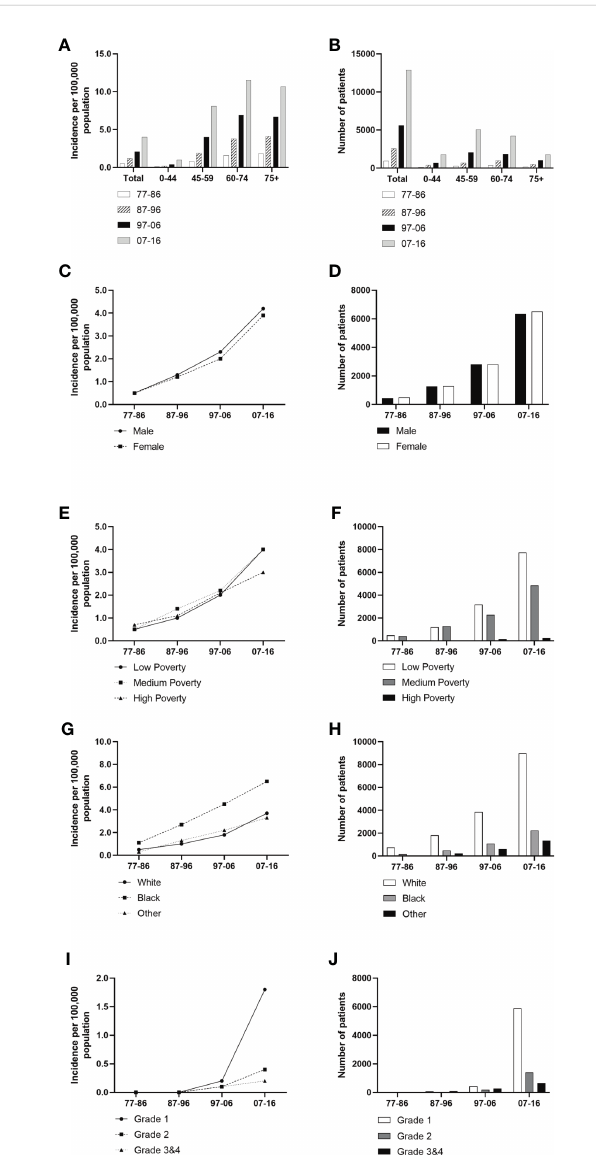
FIGURE 1 Incidence of Patients diagnosed with GI-NETs at the original nine SEER sites between 1977 and 2016. The incidence and number of GI- NETs cases are shown by age group (total and age 0-44 years, 45-59 years, 60-74 years, and over 75 years) and four-time periods. Incidence (A, C, E, G, I) and number (B, D, F, H, J) of GI-Nets cases were grouped by sex, SES, race, and grade,